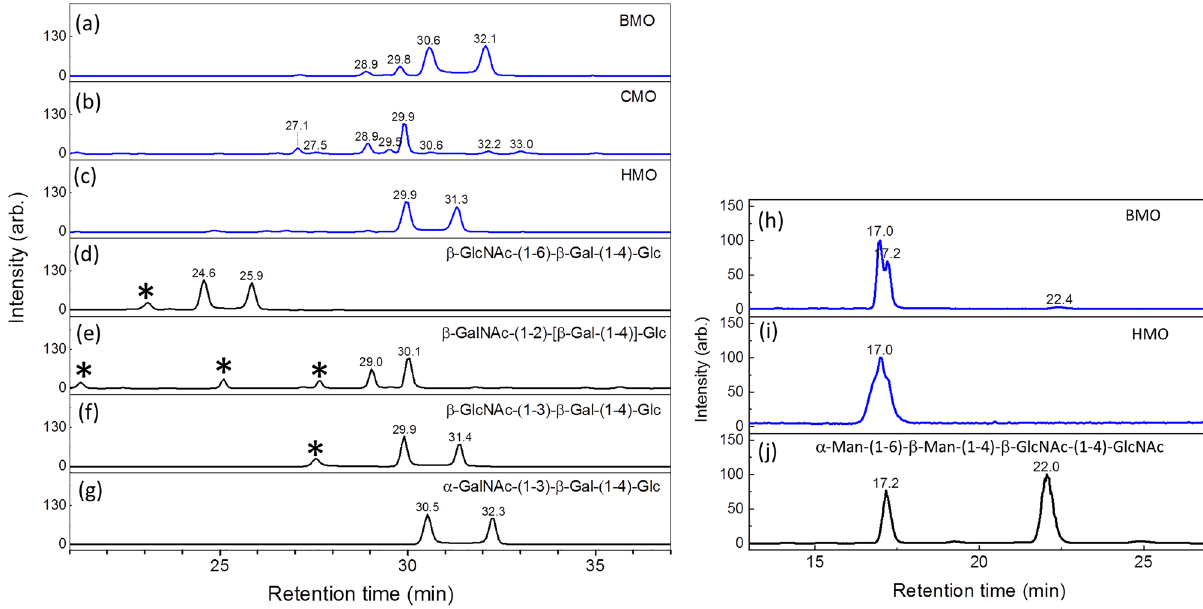
Figure 4. ( a–g ) Chromatograms of ion m/z 568, sodium adducts of (Hex) 2 HexNAc, of human milk oligosaccharides (HMO), bovine milk oligosaccharides (BMO), caprine milk oligosaccharides (CMO), and various chemically synthesized (Hex) 2 HexNAc. Peaks with symbol * represent impurity. ( h–j ): Chromatograms of ion m/z 771, sodium adducts of (Hex) 2 (HexNAc) 2 , of bovine milk oligosaccharides, human milk oligosaccharides (HMO), and synthesized α-Man-(1–6)-β-Man-(1–4)-β-GlcNAc-(1–4)-GlcNAc. α-Man-(1–6)- β-Man-(1–4)-β-GlcNAc-(1–4)-GlcNAc standard has two peaks (17.2 and 22 min), as shown in ( j ). In bovine milk, we can find a small peak at 22 min. The other peak of α-Man-(1–6)-β-Man-(1–4)-β-GlcNAc-(1–4)- GlcNAc (17.2 min) in bovine milk overlaps with another tetrasaccharide (retention time 17.0 and 17.2 time t = 37.4 and 37.8 min in Fig. 5b–e remains the same, although absolute intensity are different in different collected fractions. Thus, we can assign peaks at t = 37.4 and 37.8 min belong to one isomers according to these relative intensities. Analogous analysis shows that peaks at t = 44.1 and 44.0, peaks at 40.1 and 42.7 min, peaks at 40.6 and 41.9 min and 49.3 and 51.1 min in Fig. 5f–i belong to four different isomers, respectively, and peaks at 39.4 and 40.7 min, and 37.3 and 37.8 min in Fig. 5b–e belong to two different isomers, respectively. The results are consistent to the structural analysis using LODES/MS n . Five (Hex) 3 isomers were found in human and bovine milk and six (Hex) 3 isomers were discovered in caprine milk (Fig. 1a–c). We did not find the trisaccharide β-Gal-(1 → 4)-β-Gal-(1 → 4)-Glc in human, bovine, or caprine milk. The existence of this trisaccharide has been found previously in bovine milk 31,32,51,52 and caprine milk 53 . Rudd et al. used enzyme digestion and mass spectrometry to identify the structure of β-Gal-(1 → 4)-β-Gal- (1 → 4)-Glc in bovine milk 31 ; however, these authors did not report the discovery of this oligosaccharide in bovine milk in their later report 33 . We examined the presence of this trisaccharide by using chemically synthesized β-Gal-(1 → 4)-β-Gal-(1 → 4)-Glc. The retention times of the trisaccharide β-Gal-(1 → 4)-β-Gal-(1 → 4)-Glc in the chromatogram were located at t = 21.6 and 24.0 min (Fig. 3), but no signal was observed in the chromatograms of human, bovine, or caprine milk at the same retention time. The trisaccharide β-GlcNAc-(1 → 3)-β-Gal-(1 → 4)-Glc, which is a crucial precursor in human milk oligosac- charides for subsequent synthesis, is the dominant species of (Hex) 2 HexNAc in human milk. We did not find this trisaccharide in bovine and caprine milk, as observed by a comparison of the Hex 2 HexNAc chromatograms of human, bovine, and caprine milk in Fig. 1d–f, although the existence of this trisaccharide in bovine milk was reported in previous studies 31,33,34,53 . The trisaccharide β-GlcNAc-(1 → 6)-β-Gal-(1 → 4)-Glc was not found in human, bovine, or caprine milk 31,33 . This trisaccharide was found in bovine milk in one previous study 32 , however, it was not reported to be present as an oligosaccharide in bovine milk by the same authors in their later study 34 . In recent study, this trisaccharide was found in caprine milk, but not in bovine milk 53 . We used chemically synthesized β-GlcNAc-(1 → 6)-β-Gal-(1 → 4)-Glc to double-check whether this trisaccharide was present. No signals at the same retention times of β-GlcNAc-(1 → 6)-β-Gal-(1 → 4)-Glc were observed in the chromato- grams of human, bovine, or caprine milk (Fig. 3). Three other trisaccharides, namely α-GalNAc-(1 → 3)-β-Gal- (1 → 4)-Glc, β-GalNAc-(1 → 3)-β-Gal-(1 → 4)-Glc, and β-GalNAc-(1 → 2)-[β-Gal-(1 → 4)]-Glc, were identified in bovine milk in the present study. The presence of the first trisaccharide in bovine milk has been reported in many studies 25,31–34 , the second trisaccharide was only reported in one study 54 , and the third trisaccharide was not reported before. Trisaccharide β-GalNAc-(1 → 4)-β-Gal-(1 → 4)-Glc was reported in bovine and caprine milk in recent study 53 , but was not found in this study.